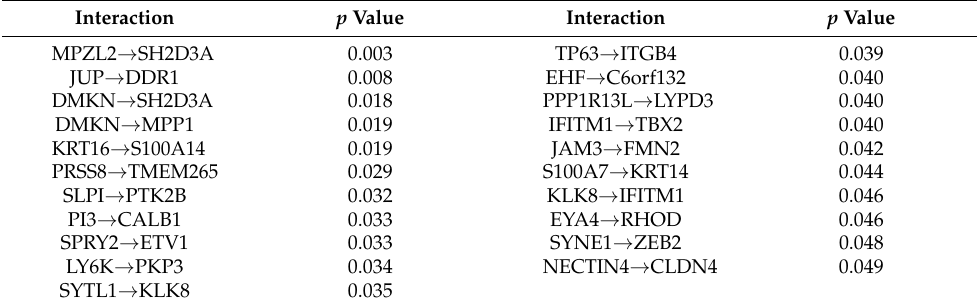
Table 1. Crucial molecular interplays to explain oxaliplatin sensitivity, where X → Y indicates interaction from regulator gene X to target gene Y . Interaction p Value Interaction p